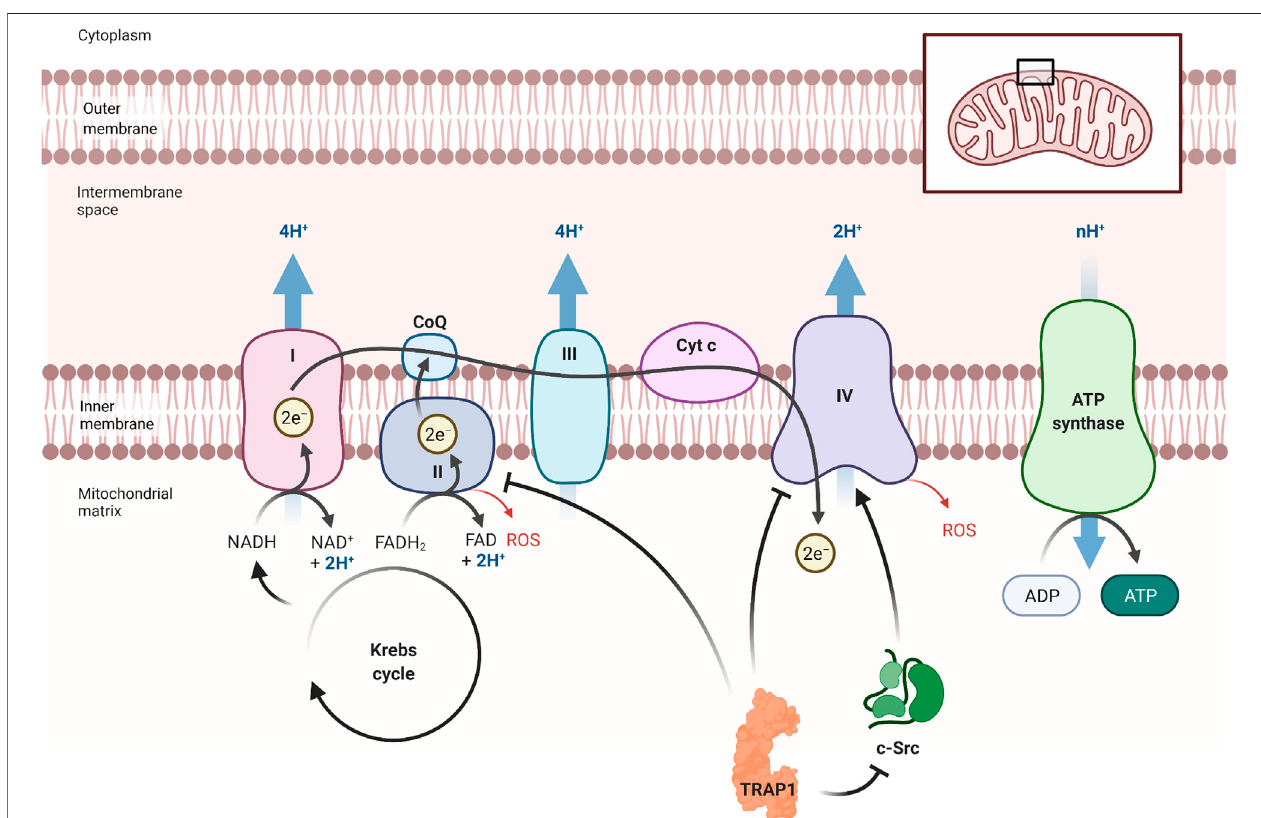
FIGURE 3 | TRAP1 ’ s in fl uence on the electron transport chain. TRAP1 can in fl uence metabolism, preferring glycolysis over OXPHOS (Joshi et al., 2020). It inhibits complex II and complex IV, which are essential in OXPHOS. TRAP1 can also inhibit Proto-oncogene tyrosine-protein kinase (c-Src), resulting in more inhibition of complexIV. By reducing OXPHOS, less ATPis produced but also less ROSare formed. Thisalso promotes theproduction ofATPunder oxygen shortage. Figure made with BioRender.